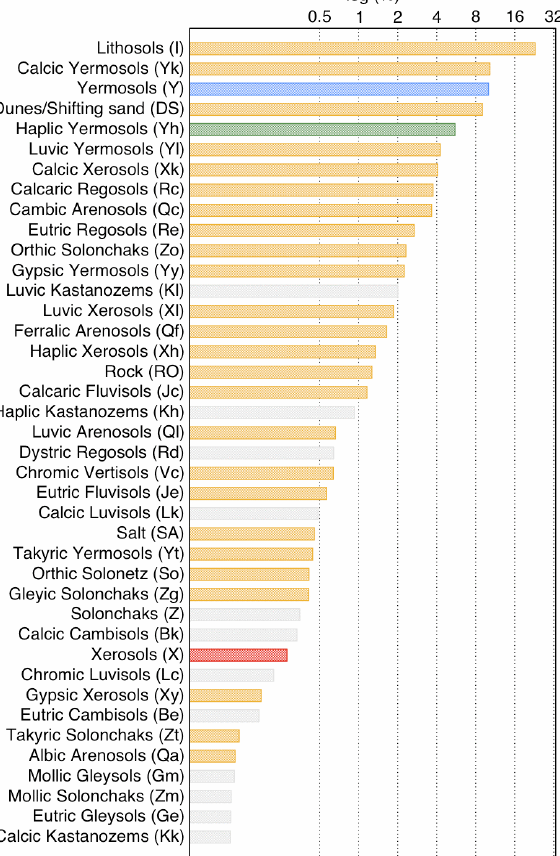
Figure 1. Fractions of the most common soil types that, in total, cover 99% of the area of the arid and bare regions on Earth. Orange denotes the soil types introduced in the MT by C99. Blue, green and red bars denote the new, added soil types in the MT. Gray denotes the soil types not included in MT.